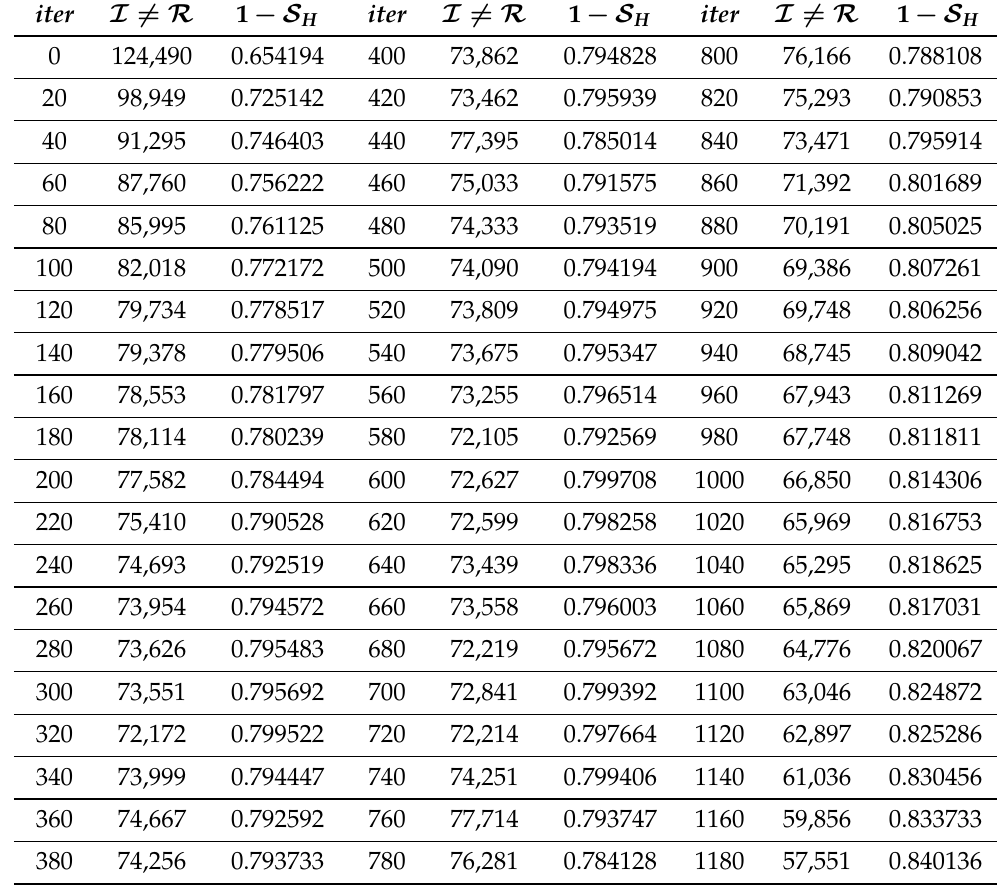
Table 1. Evolution over the generations ( iter) of the number of different pixels between the original image and the reconstructed images ( I (cid:54) = R ) and the similarity rate (1 − S H ).